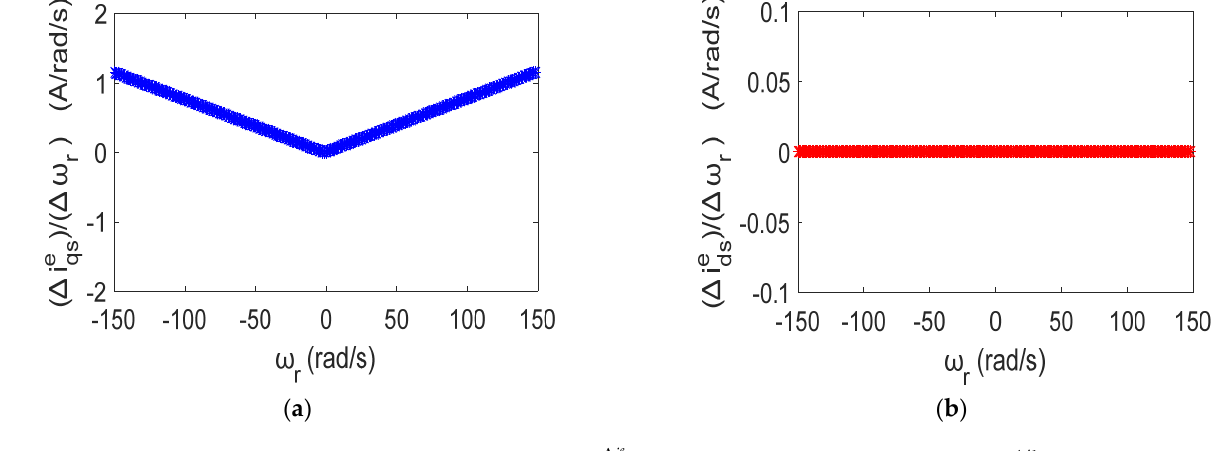
∆(cid:2919) (cid:3175)(cid:3177)(cid:3163) ∆ i e with respect to the ω (cid:2928) variation; ( b ) ∆(cid:2919) qs with respect to the ω r variation; ( b ) ∆ ω ∆(cid:2985) (cid:3176) r